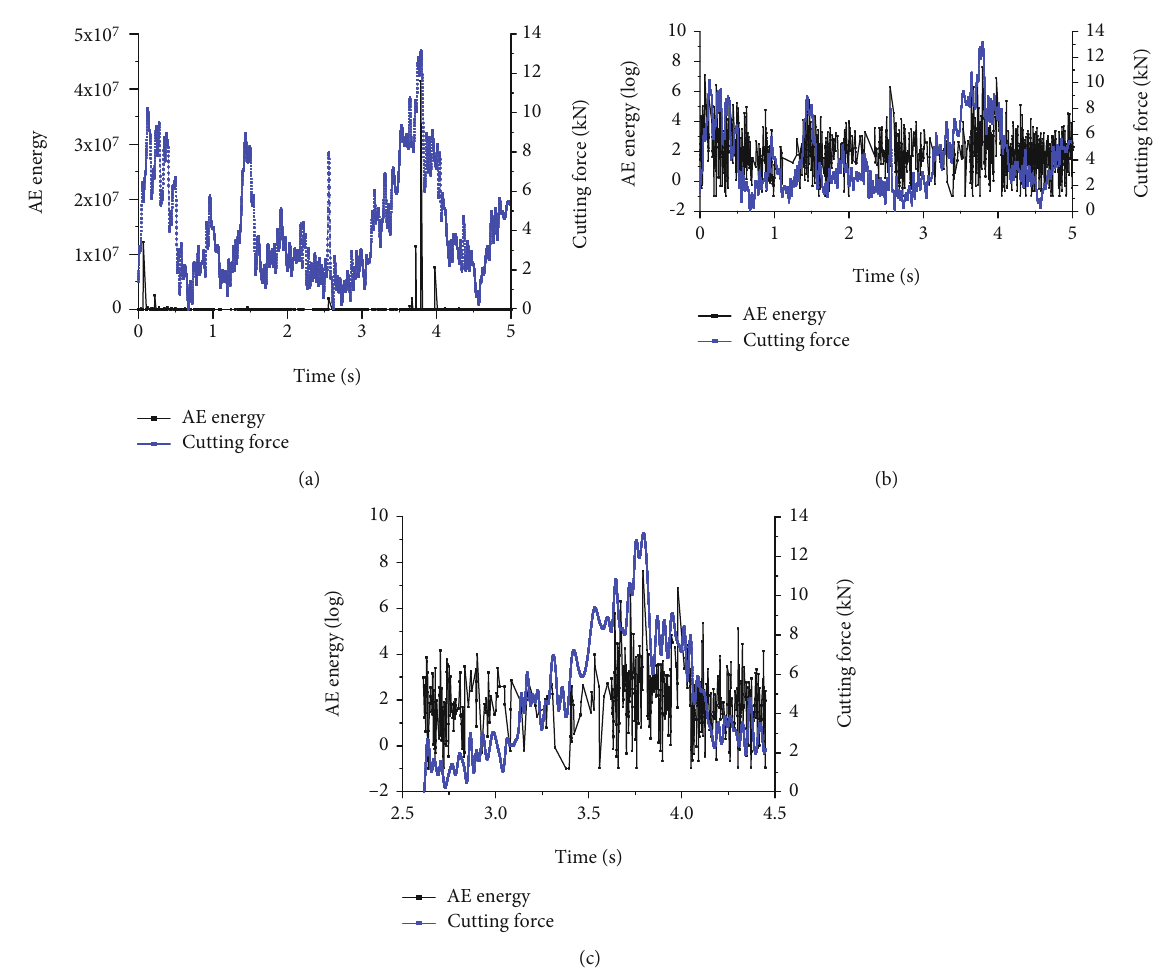
Figure 3: H coal cutting acoustic emission 2